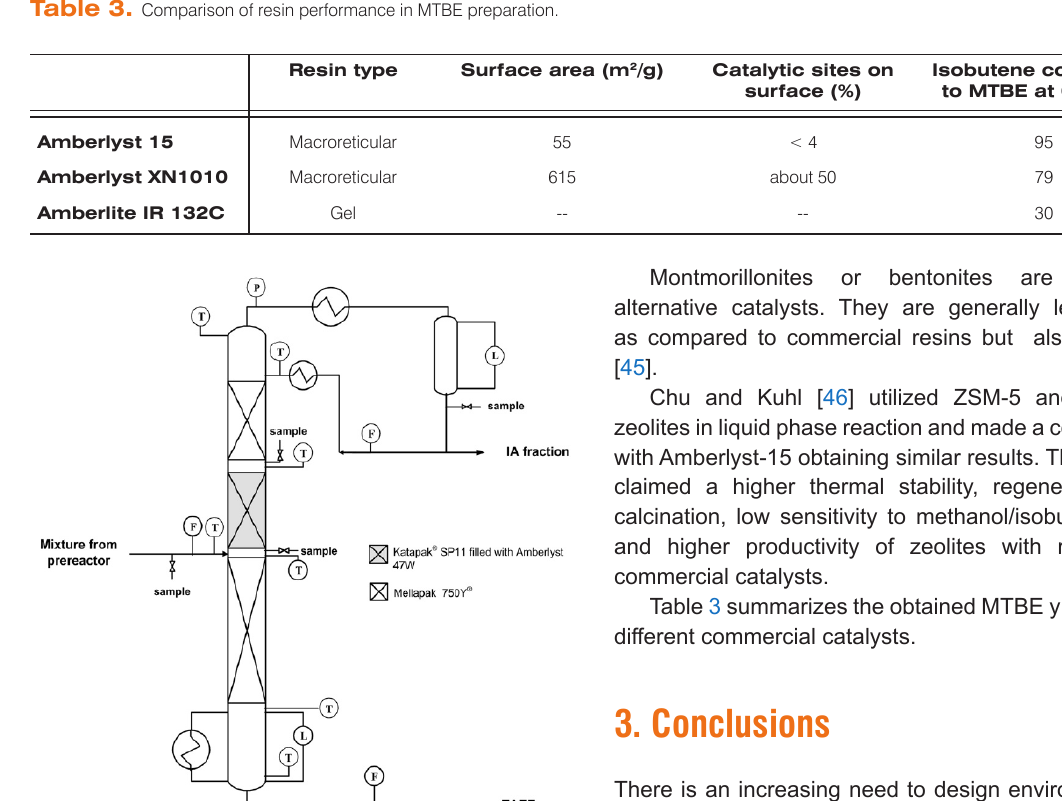
Table 3. Comparison of resin performance in MTBE